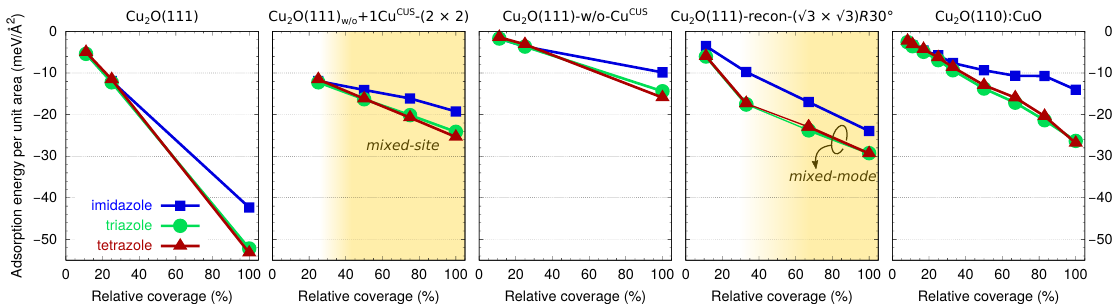
Figure 5. PBE calculated total adsorption energy per unit area, n ε ads / A , as a function of coverage (the PBE-D (cid:48)(cid:48) results display the same trend and are thus not shown). Except for triazole and tetrazole on √ √ Cu 2 O(111)-recon-( 3 × 3) R 30 ◦ , the molecules prefer to adsorb non-dissociatively. The yellowish regions √ √ on graphs for Cu 2 O(111) w/o +1Cu CUS –(2 × 2) and Cu 2 O(111)-recon-( 3 × 3) R 30 ◦ surfaces indicate the regions of mixed-site and mixed-mode adsorption, i.e., on the former the molecules adsorb onto Cu CUS sites up to the coverage of r 25%, at which all the Cu CUS sites are occupied, and above it the molecules adsorb √ √ onto remaining surface sites, whereas on Cu 2 O(111)-recon-( 3 × 3) R 30 ◦ triazole and tetrazole adsorb dissociatively onto Cu Ovac sites up to the coverage of r 33% and above it